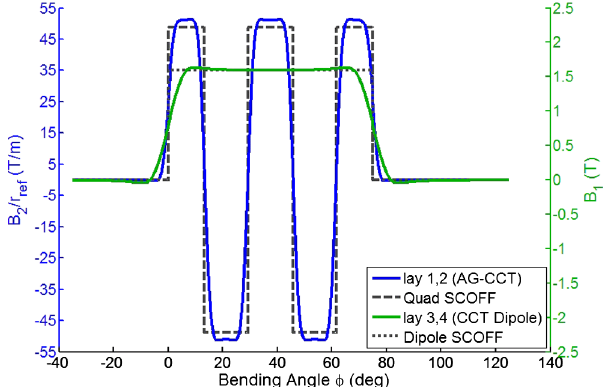
FIG. 12. The dipole (B 1 ) and alternating quadrupole (B 2 =r contributions from the CCT dipole and AG-CCT layers are shown as a function of bending angle for the 75 degree bend (B1, B2). Note that r is the bore radius which is listed in Table ref